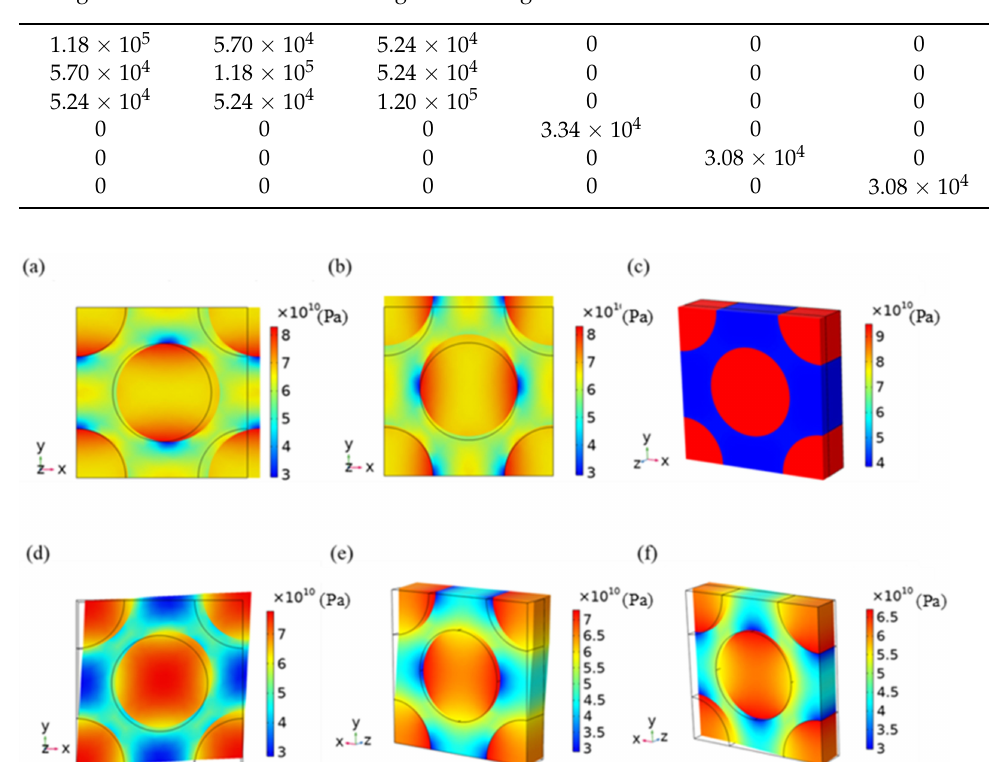
Figure 8. The von Mises stress (Pa) distribution cloud diagram of the EAS-Nb 3 Sn level 1 homogeneous fiber bundle considering fiber damage, when T = 4 K, and ε = 0.003. ( a ) Load case 1: von Mises stress (N/m 2 ). ( b ) Load case 2: von Mises stress (N/m 2 ). ( c ) Load case 3: von Mises stress (N/m 2 ). ( d